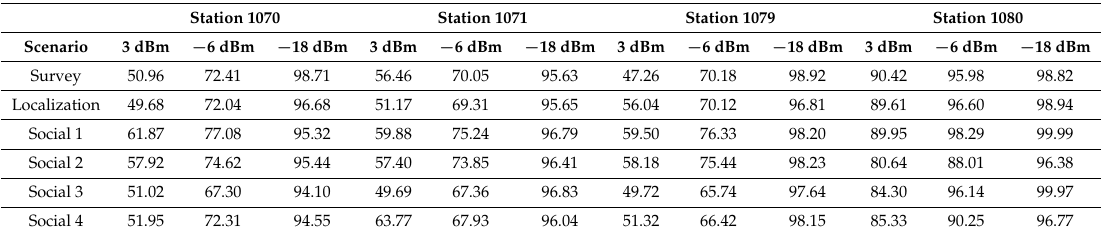
Table 7. Packet loss rate experimented by Anchors 1070, 1071, 1079 and 1080. Station